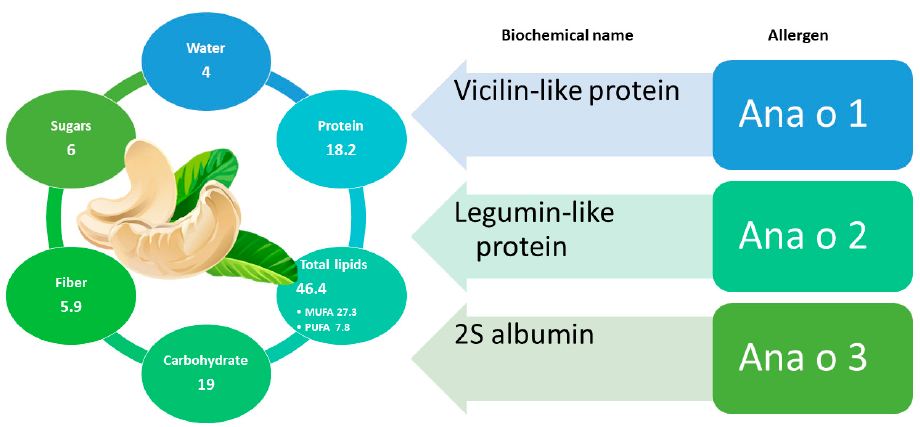
Figure 4. ( Left ) relevant information on the nutritional composition (g/100 g) relating to the Anacardium occidentale species. ( Right ) list of allergenic proteins identified and registered to date on the WHO/IUIS online allergen platform.